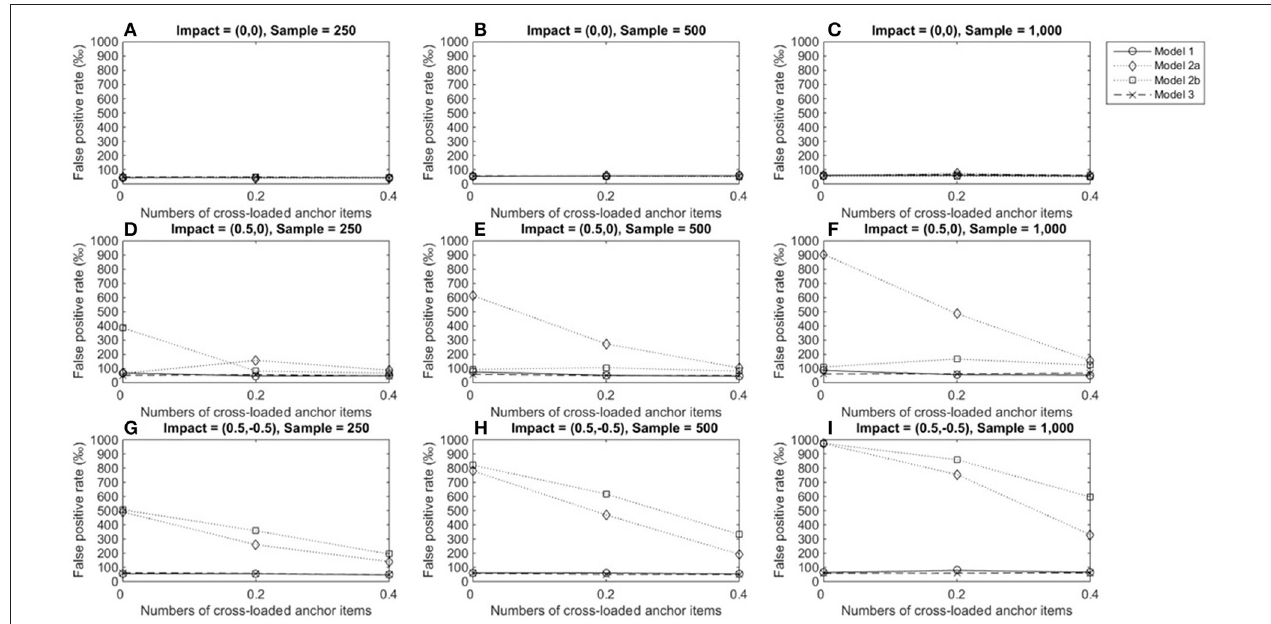
FIGURE 5 | False positive rates when the tested item measured two domains. Fore model 1, total score served as a matching variable; for model 2a, the subset score of domain 1 was used to match participants; for model 2b, the subset score of domain 2 used to match participants; model 3 used two subset scores as a matching variable. (A) Impact = (0,0), Sample = 250; (B) Impact = (0,0), Sample = 500; (C) Impact = (0,0), Sample = 1,000; (D) Impact = (0.5,0), Sample = 250; (E) Impact = (0.5,0), Sample = 500; (F) Impact = (0.5,0), Sample = 1,000; (G) Impact = (0.5, − 0.5), Sample = 250; (H) Impact = (0.5, − 0.5), Sample = 500; (I) Impact = (0.5, − 0.5), Sample = 1,000.